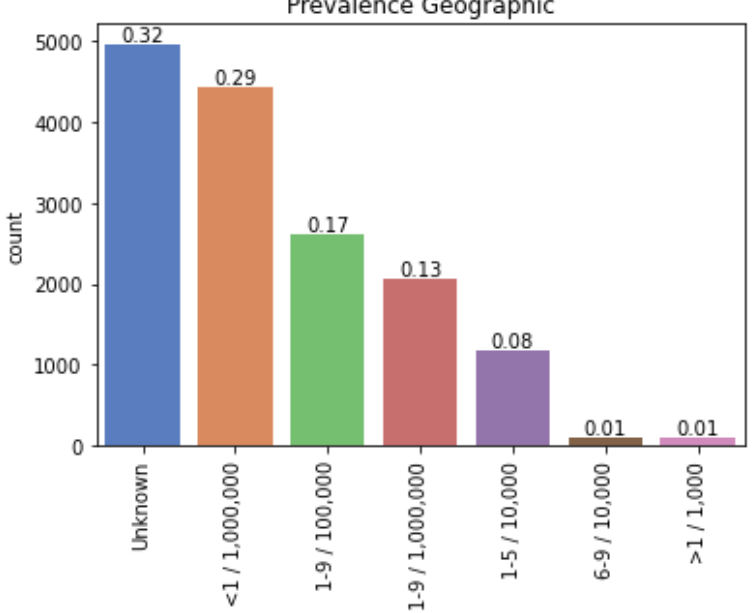
Figure 1. Representation of the distribution of the different prevalence values in the set of rare diseases present in Orphanet.